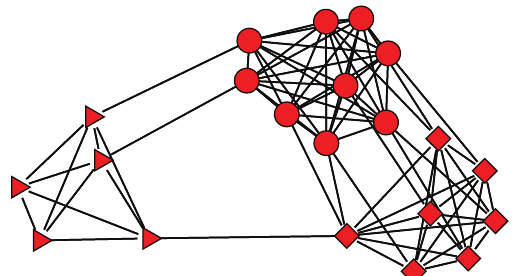
Figure 1: Example of hierarchical modular network